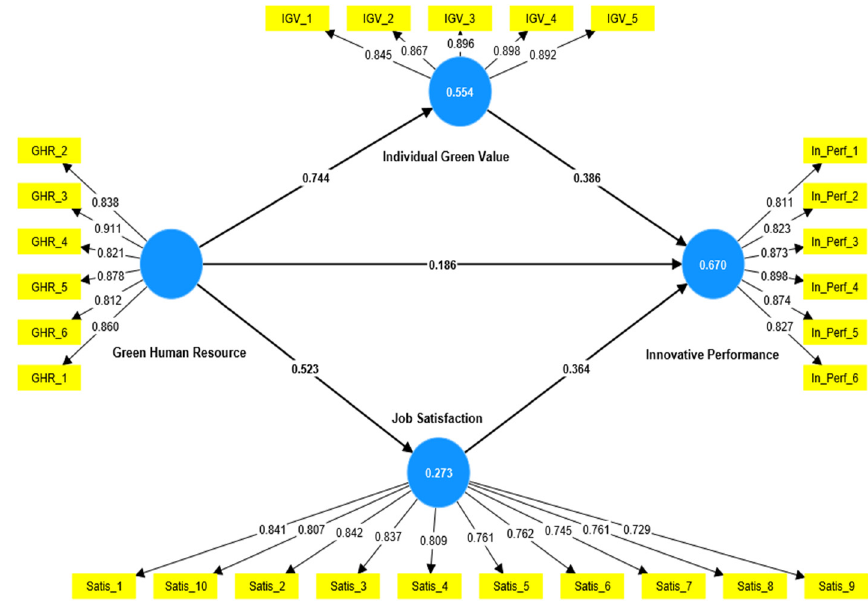
Figure 2. The study model from the smart PLS4 program.